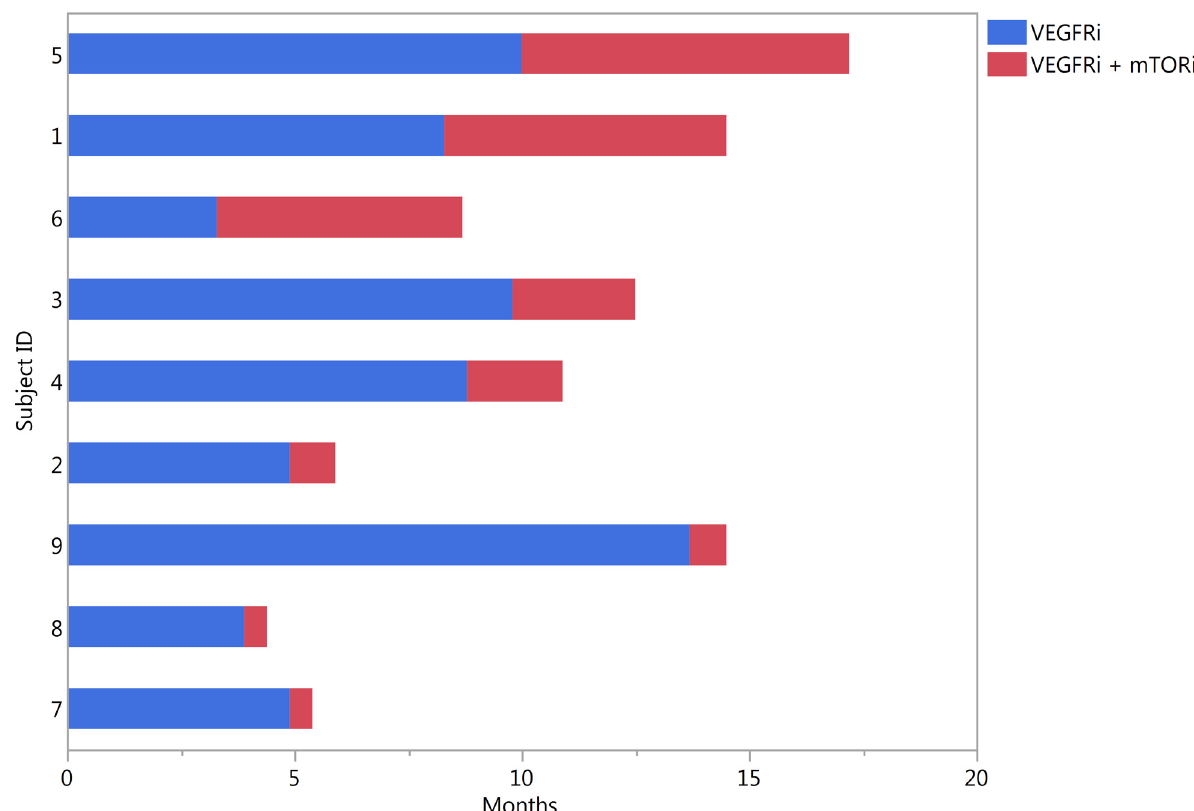
Fig 2. Stacked bar chart of response duration to VEGFRi & VEGFRi + mTORi. VEGFRi = vascular endothelial growth factor receptor inhibitor; mTORi = mammalian target of rapamycin inhibitor Subject 5 remains on pazopanib and everolimus